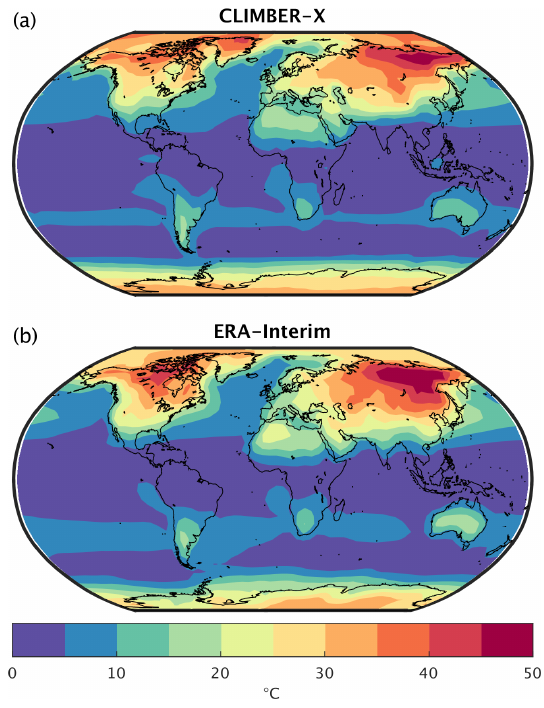
Figure 7. Near-surface air temperature seasonality in (a) CLIMBER-X compared to (b) ERA-Interim reanalysis (Dee et al., 2011) computed as the difference between maximum and minimum monthly